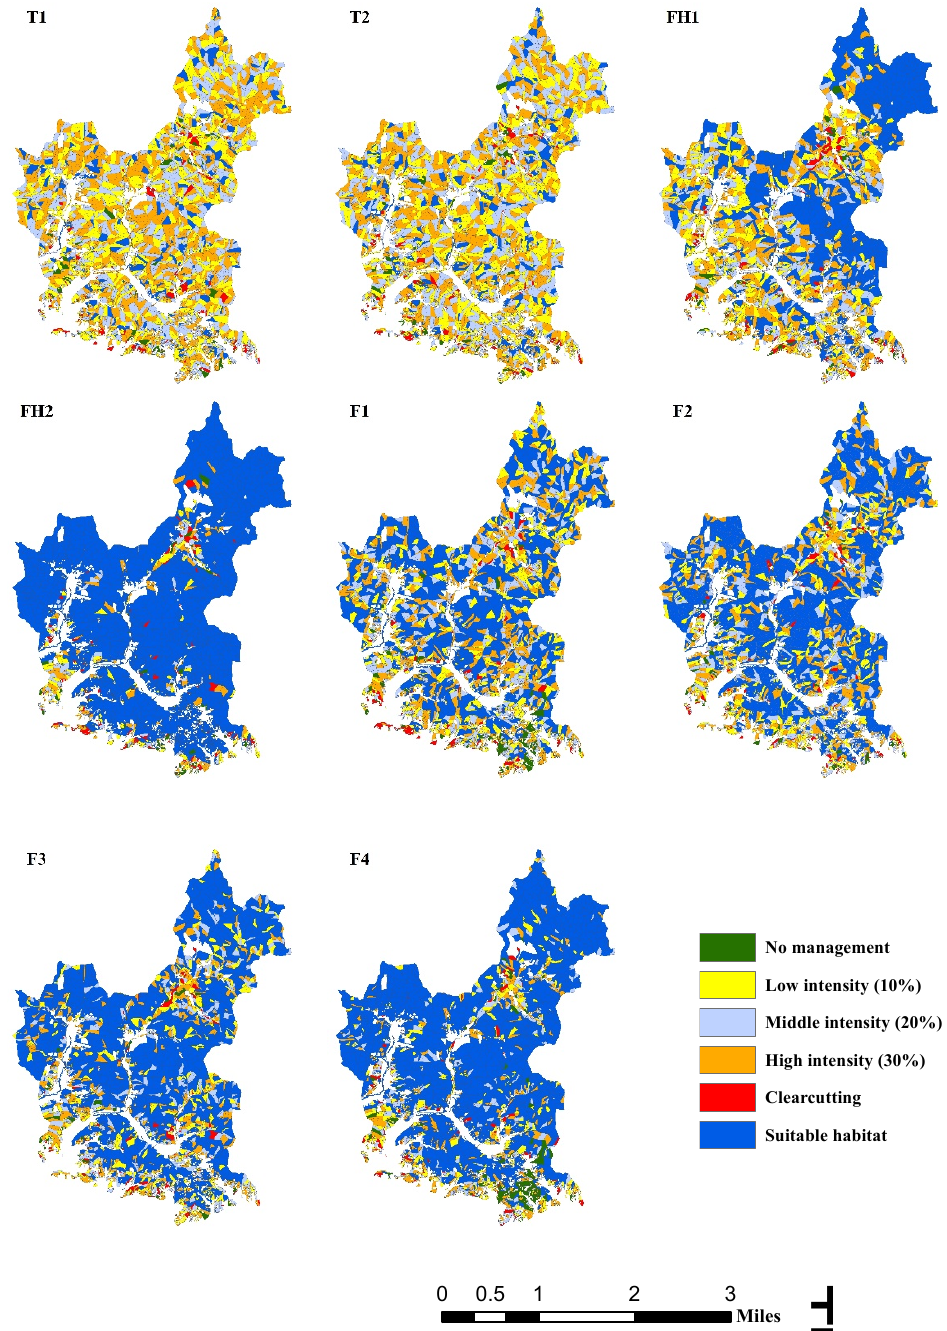
Figure 5. The spatial assignment of optimal management prescriptions of various alternative strat- egies for timber production at Maoershan Forest Farm, China: timber-oriented management strategy (TMS, scenarios T1 and T2), fixed selection of suitable habitat management strategy (FSSHMS, scenarios FH1 and FH2), and free selection of restricted suitable habitat management strategy (FSRSHMS, scenarios F1 to F4).